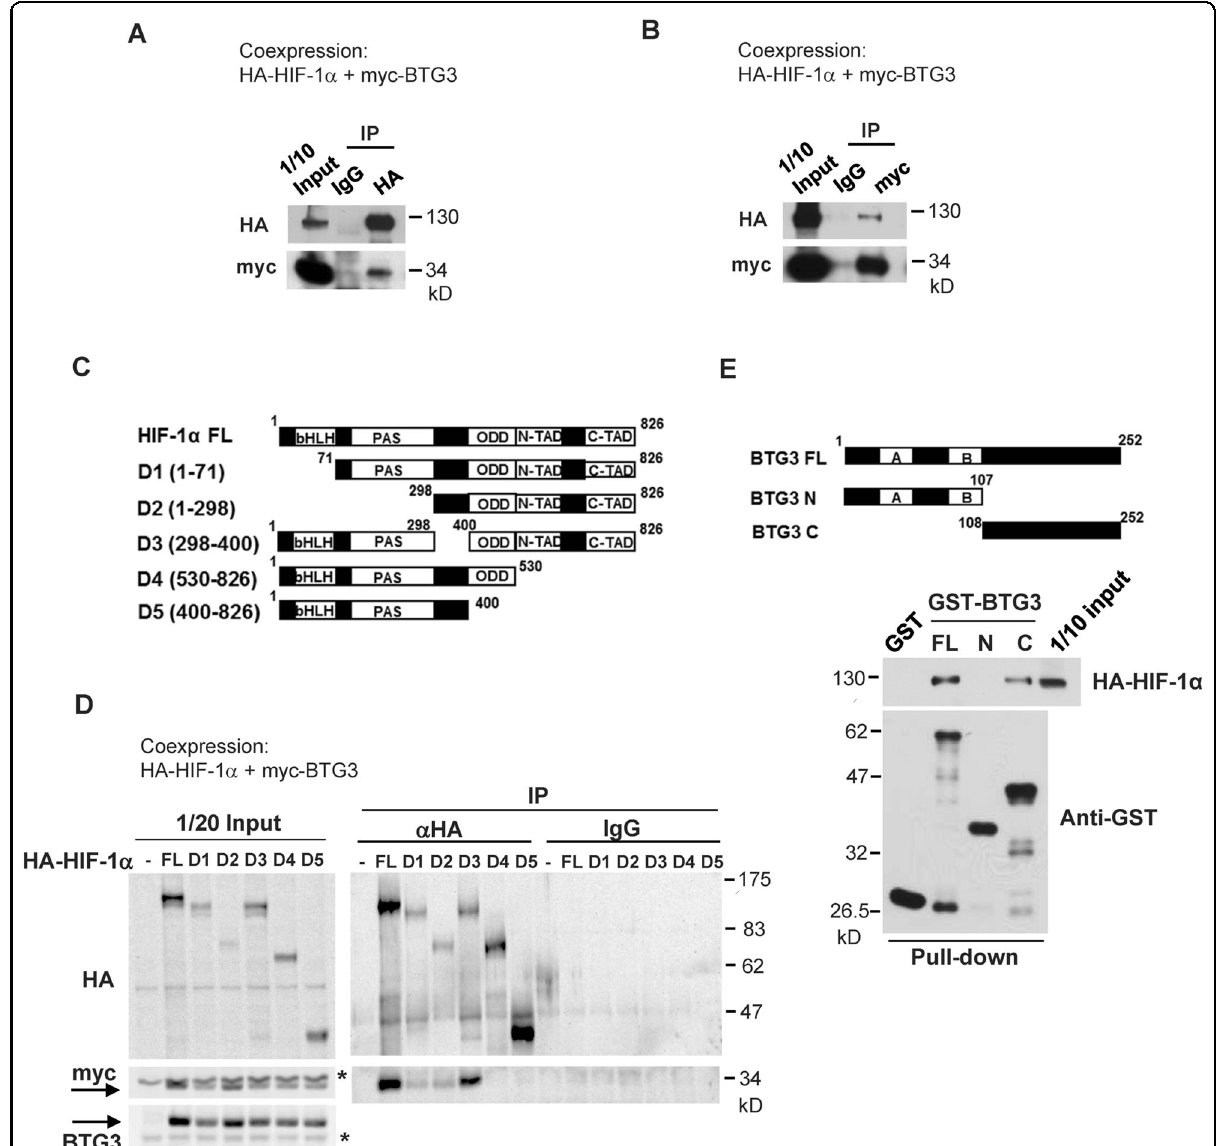
Fig. 3 Interaction between BTG3 and HIF-1 α . a , b Coexpression and coimmunoprecipitation of HA-HIF-1 α and myc-BTG3. Lysates from transfected 293T cells were immunoprecipitated with anti-HA ( a ) or anti-myc ( b ). c Schematic diagrams of full-length (FL) HIF-1 α and its various truncation or deletion mutants. d BTG3 binds the HIF-1 α C-terminal transactivation domain. Co-immunoprecipitation was performed as in ( a , b ) with either FL HIF- 1 α or the indicated mutant. e Direct interaction of BTG3 with HIF-1 α . GST pulldown assay was performed to show that recombinant BTG3 interacts with HIF-1 α through the BTG3 C-terminal